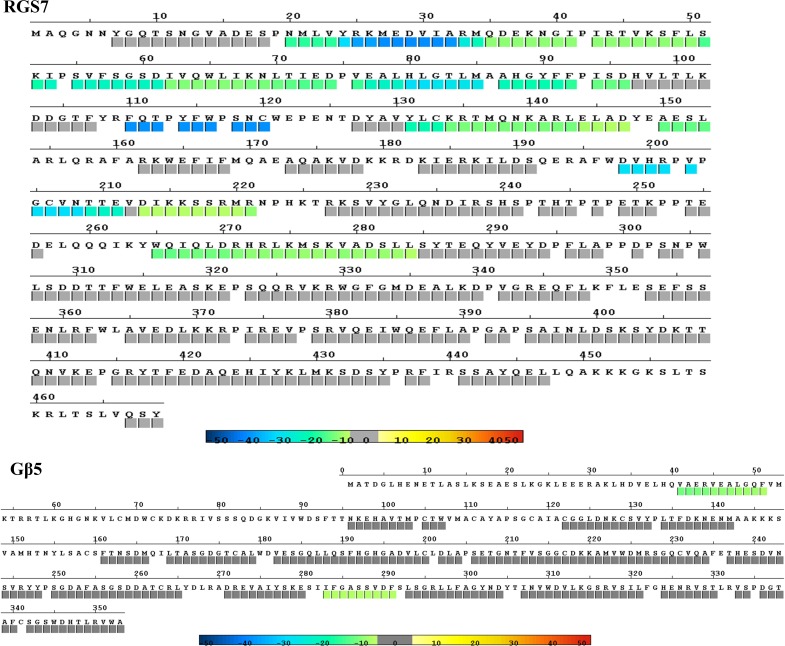
Differential mapping of changes in HDX of RGS7 and Gβ5 induced by R7BP binding.Peptides whose HDX was significantly changed in the presence of R7BP are colored and mapped onto the RGS7 and Gβ5 sequences. Color coding as in Figure 6b. Raw HDX data are deposited at: https://doi.org/10.6084/m9.figshare.7316462.v2.